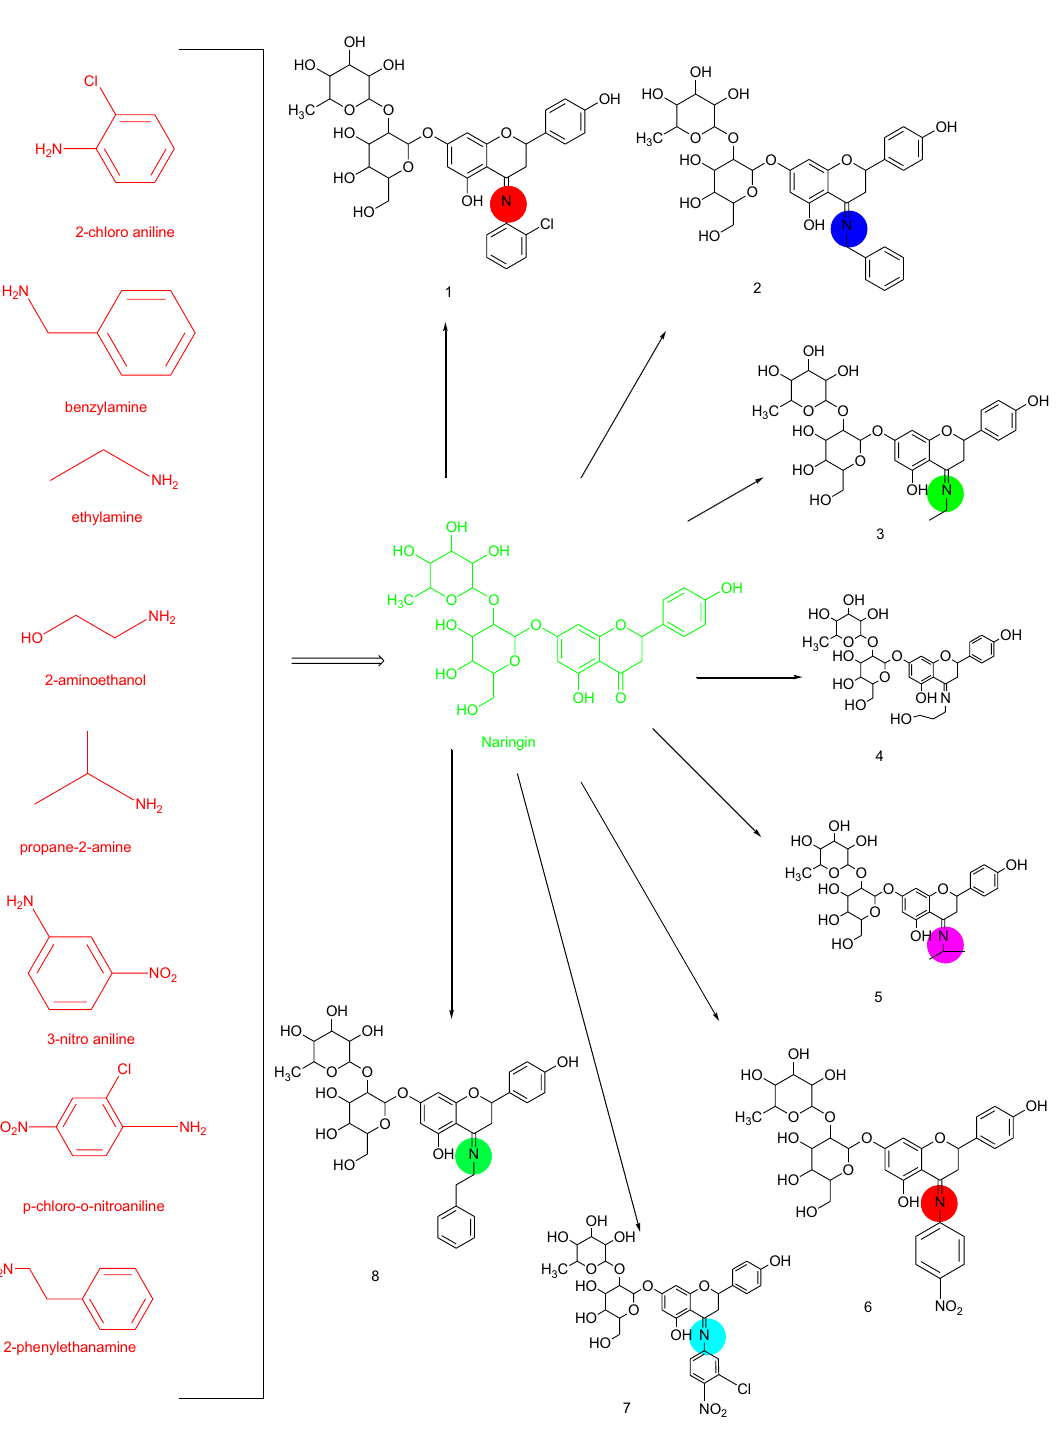
Figure 4. Design of the strategy of naringin derivatives for G-6-P synthase inhibition and antioxidant